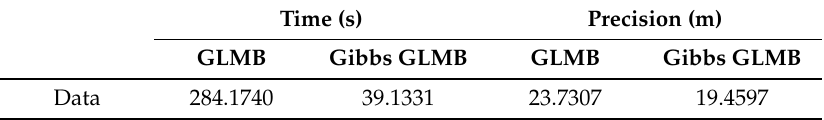
Table 4. The running time and precision of filters (the average of 10 times) for experiment